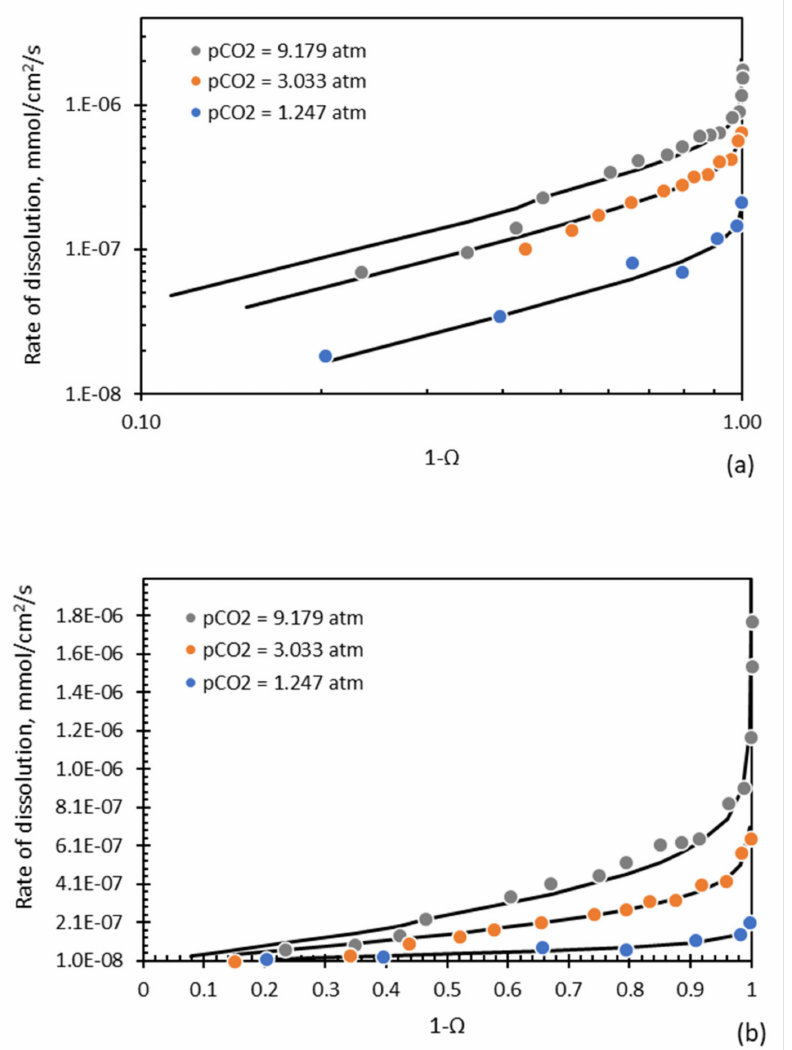
Figure 13. The effect of the degree of saturation, Ω , on the rate of dissolution of calcite from the data of Busenberg and Plummer [77] as ( a ) a log–log plot and ( b ) a normal coordinate plot. These results highlight the non-linearity with respect to 1 − Ω as 1 − Ω approaches 1. The lines represent Equation (33) fitted to the